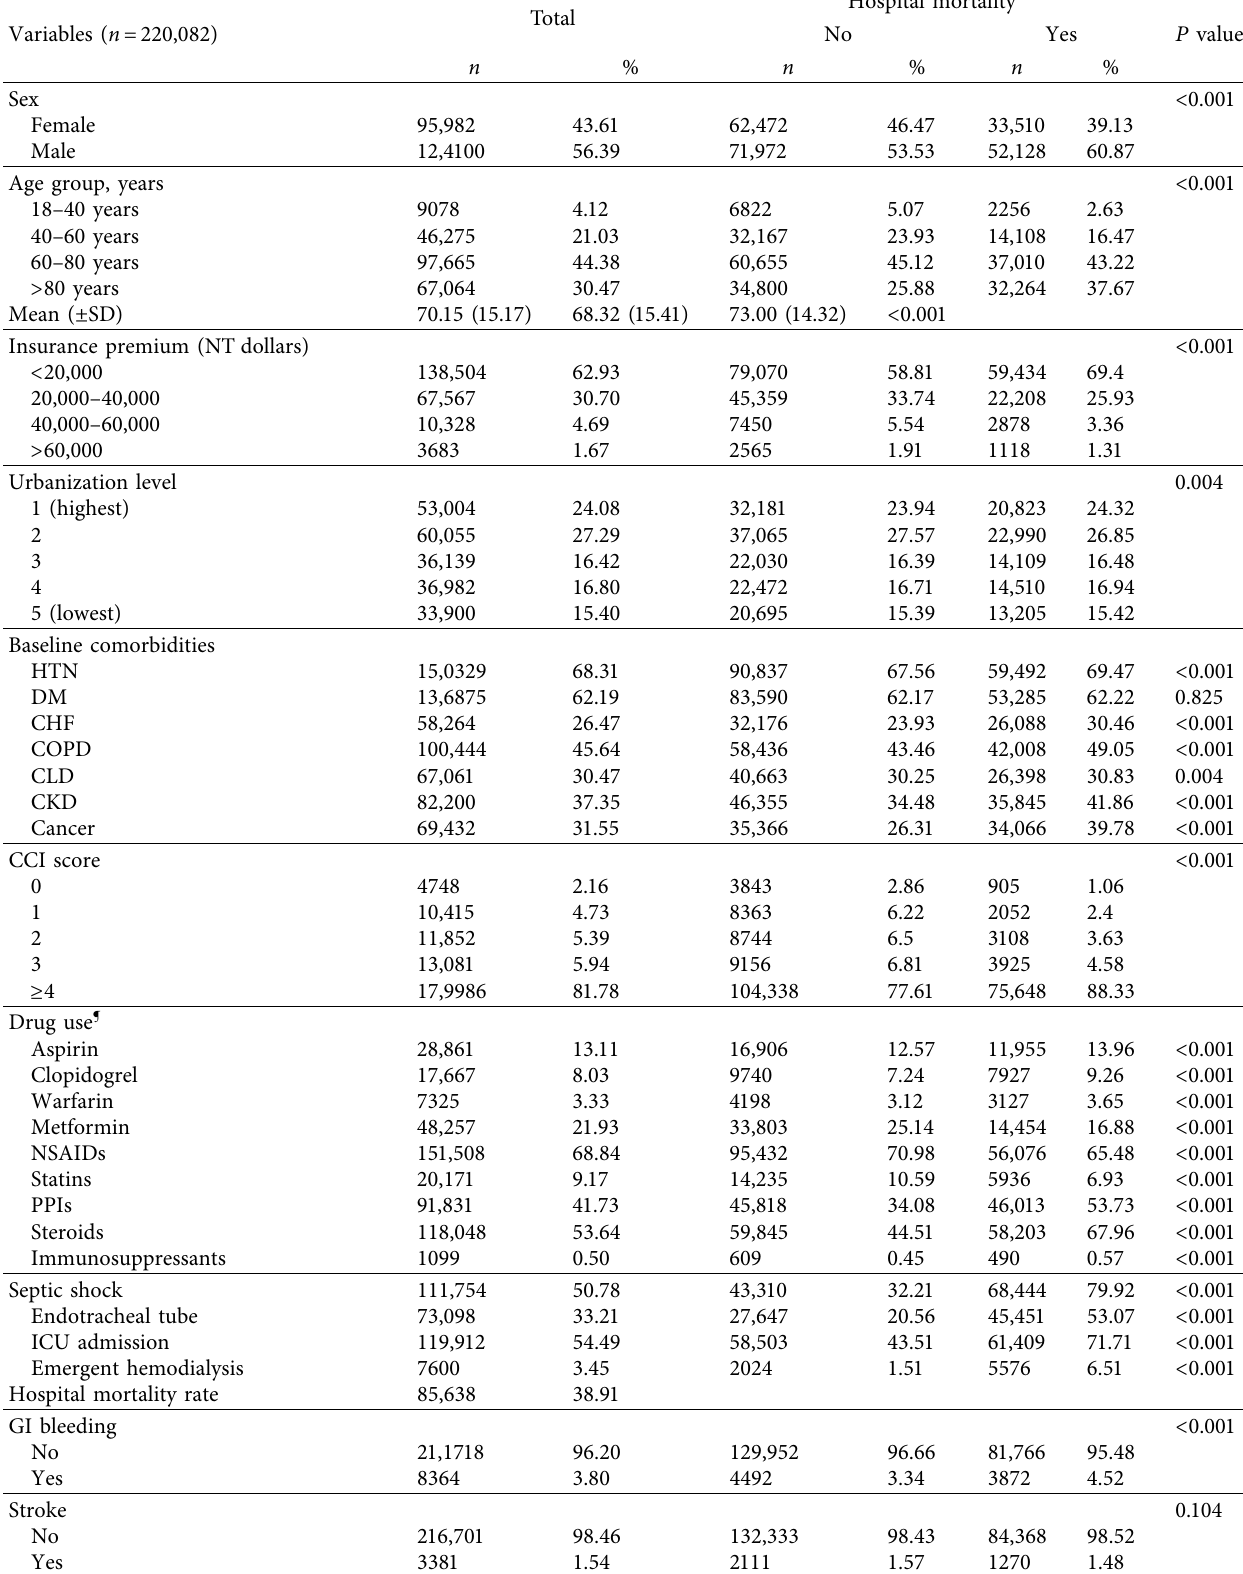
Table 1: Demographic characteristics and baseline comorbidities of sepsis